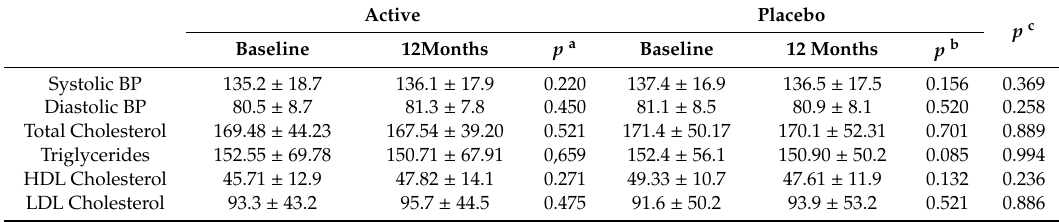
Table A2. Blood Pressure and lipid profile at baseline and end of intervention for both